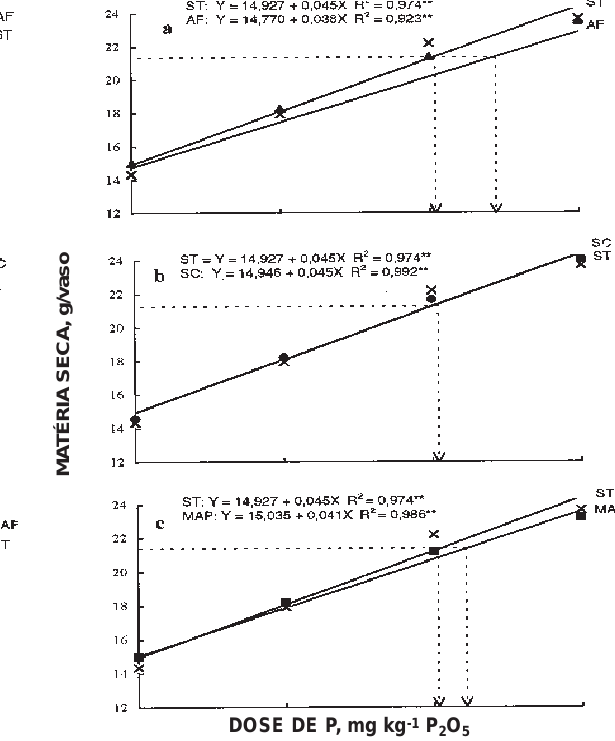
Figura 1. Produção de matéria seca das plantas de milho, em função de doses de fosfato no latossolo vermelho-amarelo, unidade Itororó. A inclusão das linhas pontilhadas ilustra o cálculo do equivalente em superfosfato triplo (EqST) para o ácido fosfórico (a), suspensão coloidal 10-30-00 (b) e fosfato monoamônico (c) (AF: ácido fosfórico; SC: suspensão coloidal 10-30-00; MAP: fosfato monoamônico; e ST: superfosfato triplo).